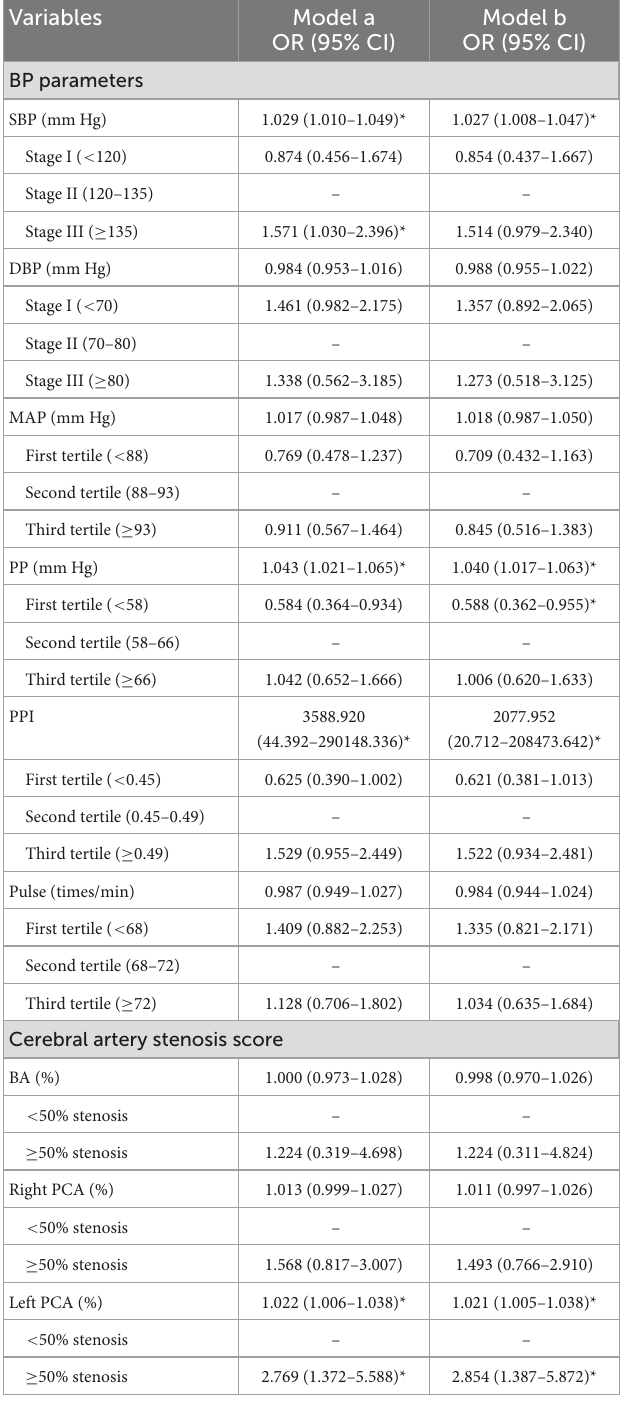
TABLE 2 Logistic regression analysis for the relationship between risk factors and CI.